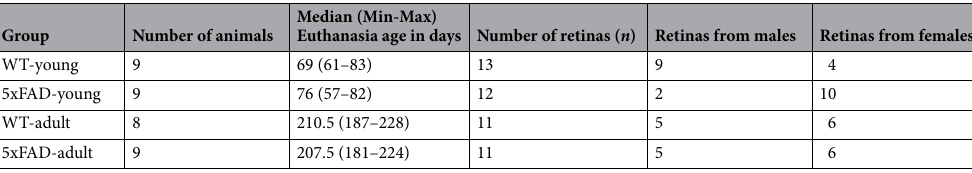
Table 3. Gender and age characteristics of the four